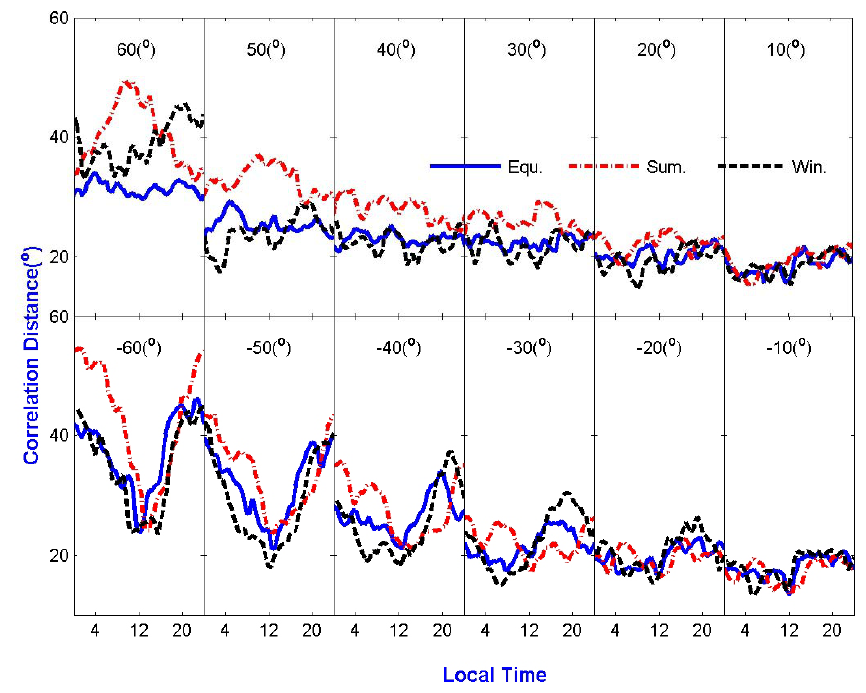
Figure 4. Local time variations of zonal correlation distance for the selected latitudes for equinox (solid lines), summer (dash-dot lines), and winter (dashed lines), respectively.